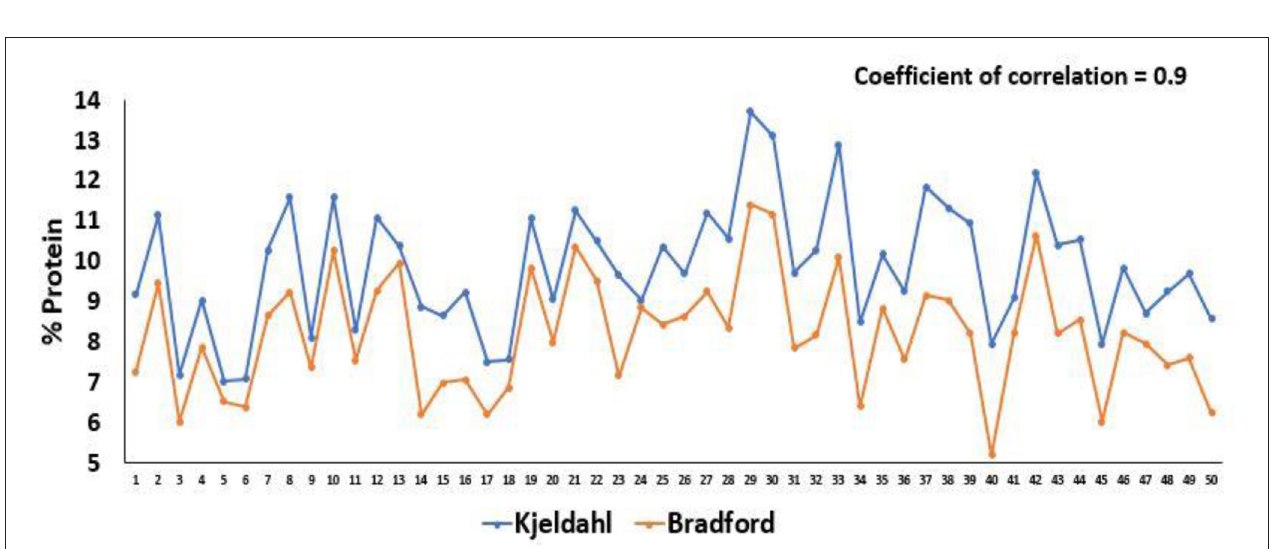
FIGURE 6 | Protein content estimated by micro-Kjeldahl and Bradford methods in 51 experimental lines.